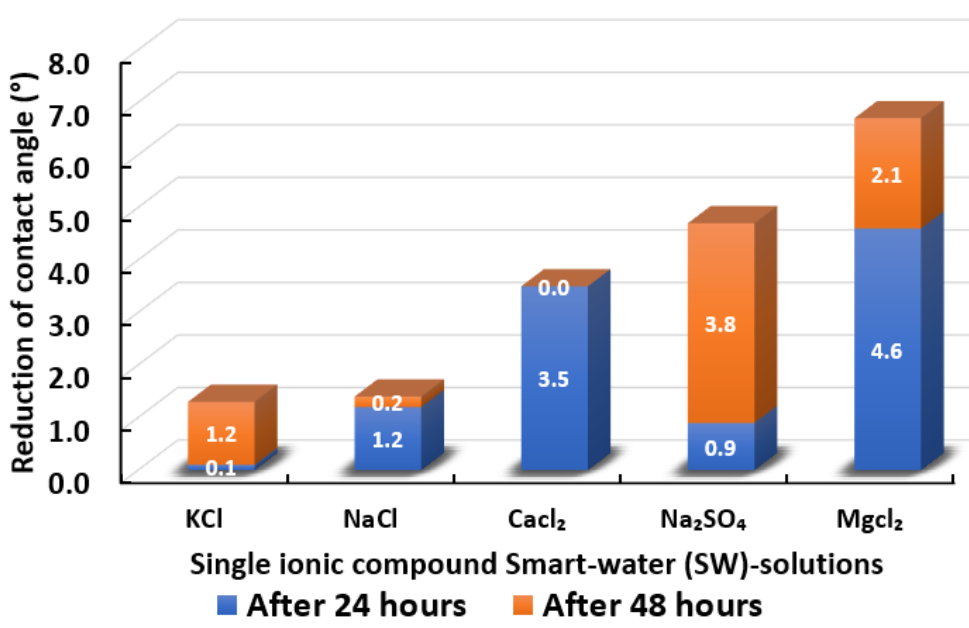
Figure 15. Contact angle reduction results for single ionic compounds smart water (SW) solutions (3500